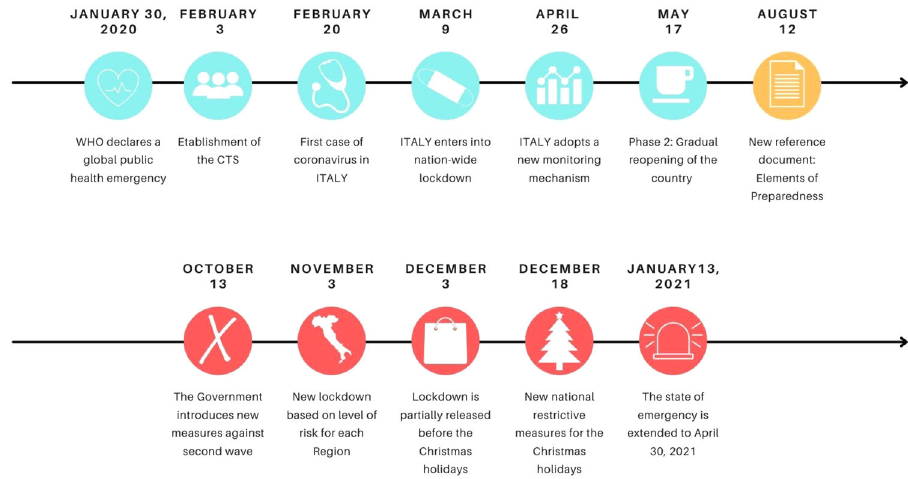
Fig. 1 Timeline of key events in the Covid-19 outbreak in Italy in 2020. Figure